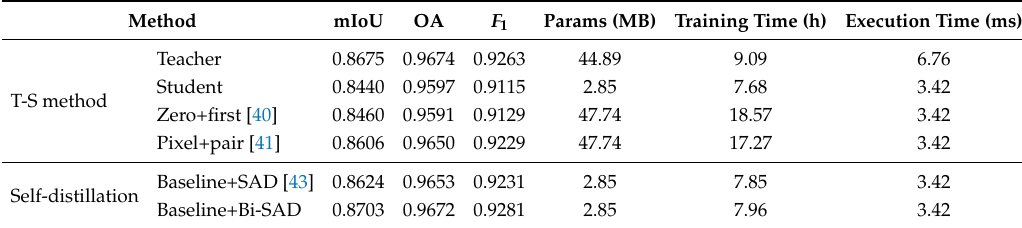
Table 3. Comparison of the state-of-the-art distillation methods in [40,41,43] with ours. The segmentation is evaluated by mIoU. “Zero” in the third row of the table represents the pixel-wise L 2 norm distillation method in [40]. “first” in the third row represents the local similarity distillation method in [40]. “Pixel” in the fourth row represents the pixel-wise probability mimicking method in [41]. “pair” in the fourth row represents the global pair-wise distillation in [41]. “SAD” in the fifth row represents the self-attention distillation method in [43]. “Bi-SAD” in the last row represents our self-attention learning